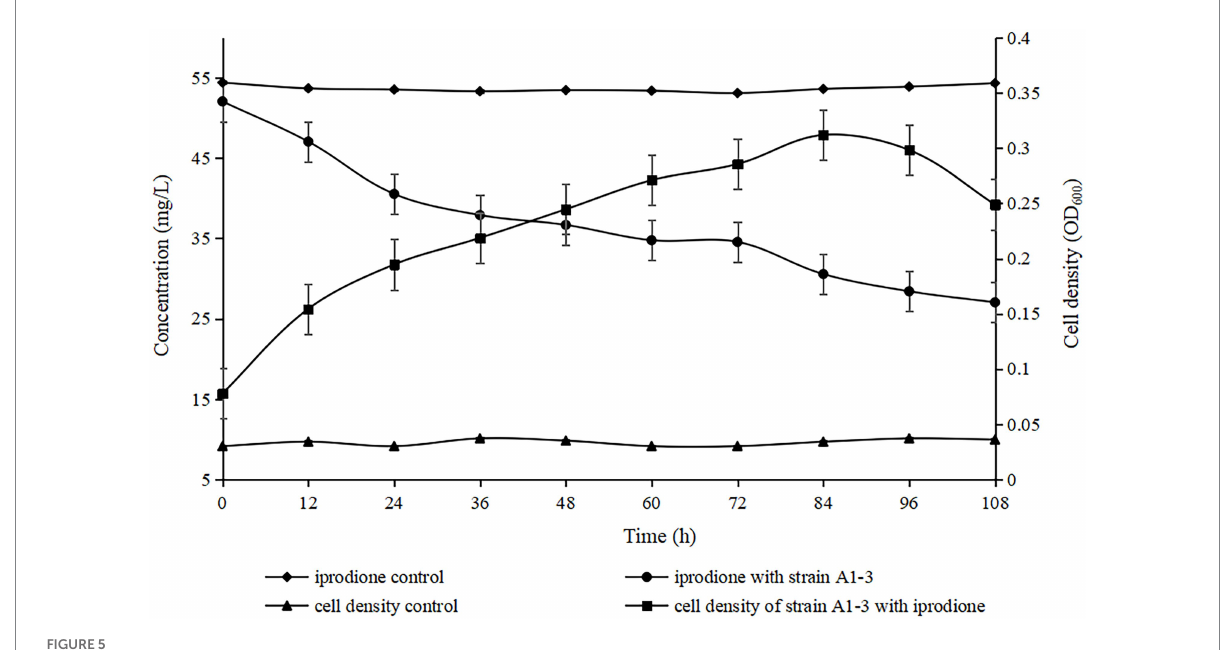
FIGURE 5 Utilization of iprodione by Azospirillum sp. A1-3.